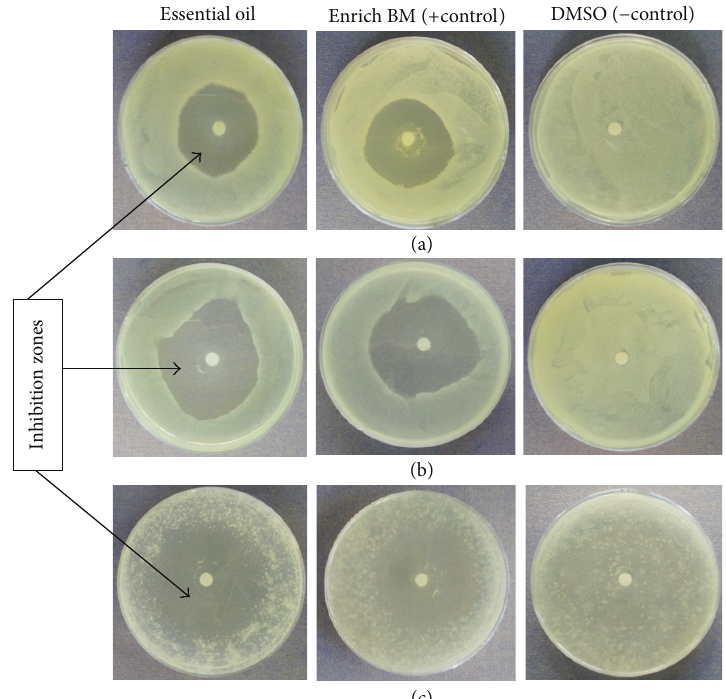
Figure 1: Inhibition zones of Tagetes minuta essential oils against X. axonopodis pv . manihotis (a), X. axonopodis pv . phaseoli (b), and P. savastanoi pv . phaseolicola (c) after 48 hours.